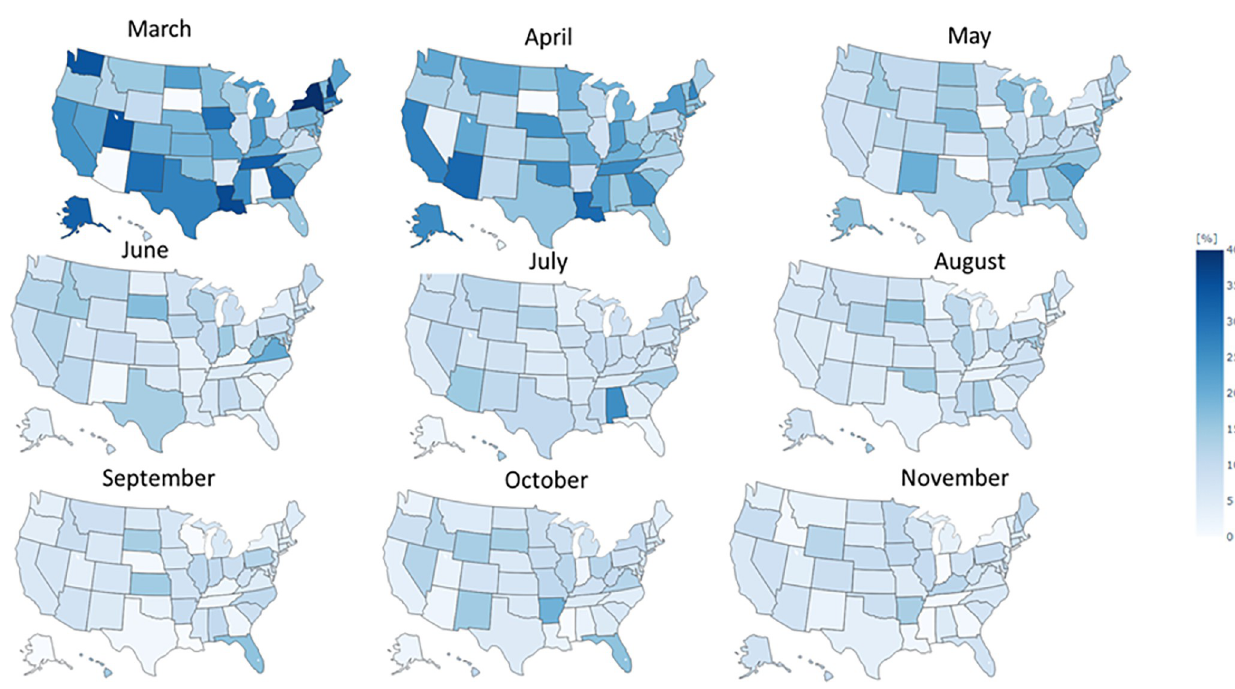
Fig 3. Normalized frequency of press–releases per state.